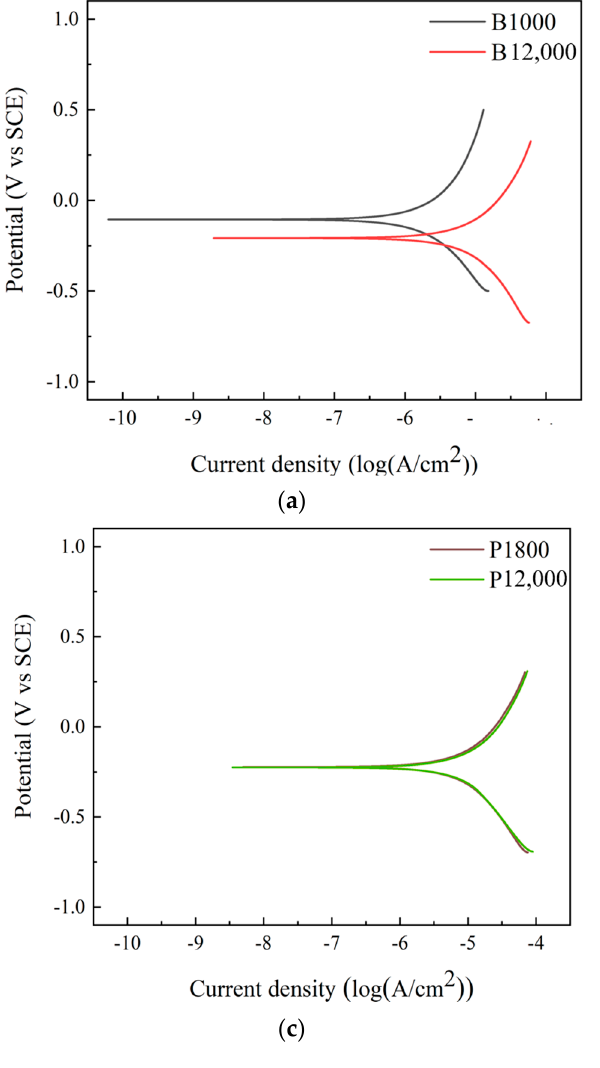
Figure 8. The graphs of the kinetic potential polarization curves for the coating obtained via the MAO treatment in the ( a ) Na 2 B 4 O 7 , ( b ) NaF, ( c ) Na 3 PO 4 , and ( d ) Na 2 SiO 3 electrolytes. Table 3. Fitting results of the potentiodynamic polarization curves.